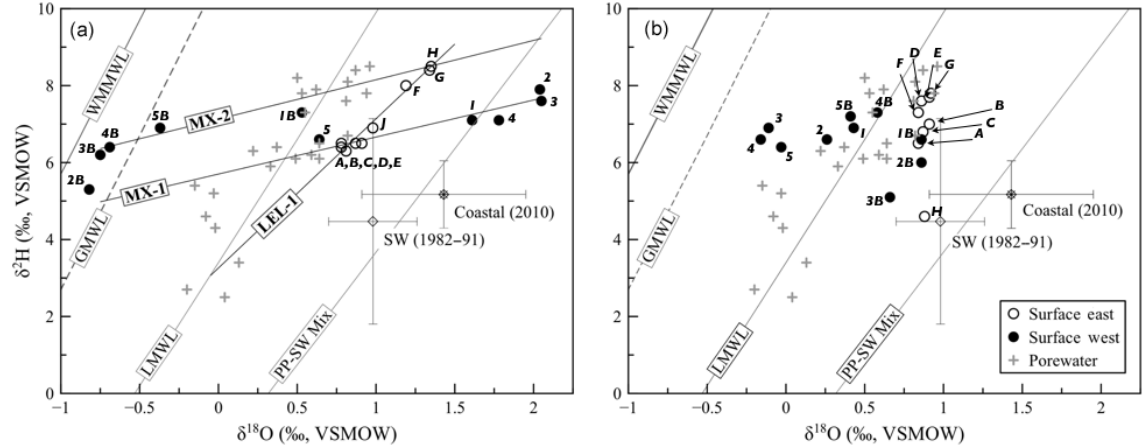
Figure 6. Tidal variability of the isotopic composition of surface waters in the lagoon, framed by significant local evaporation (LEL), mixing (MX), and meteoric lines, as well as the average composition of adjacent coastal water and seawater (historic data). (a) Low tide and (b) high tide. For more details, see Sects. 4.2.4 and